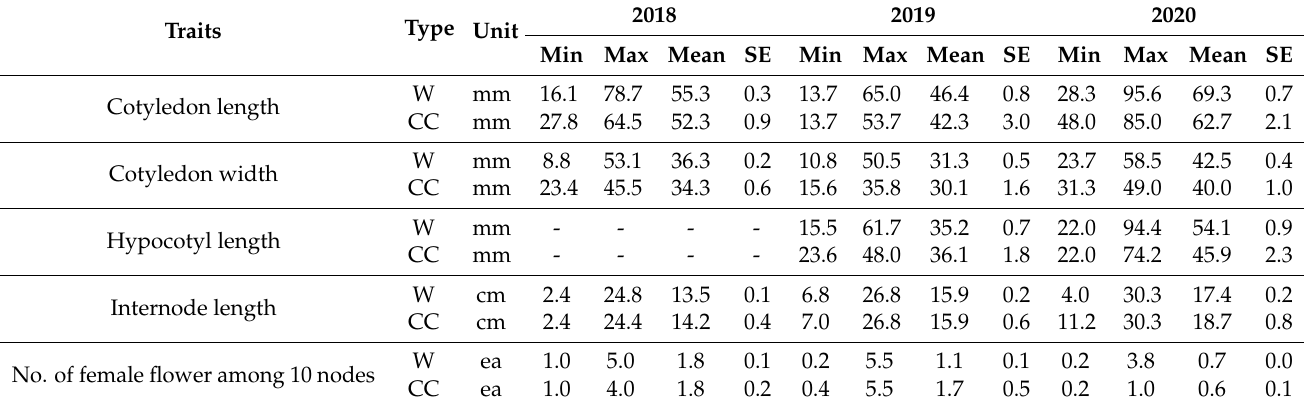
Internode length No. of female flower among 10